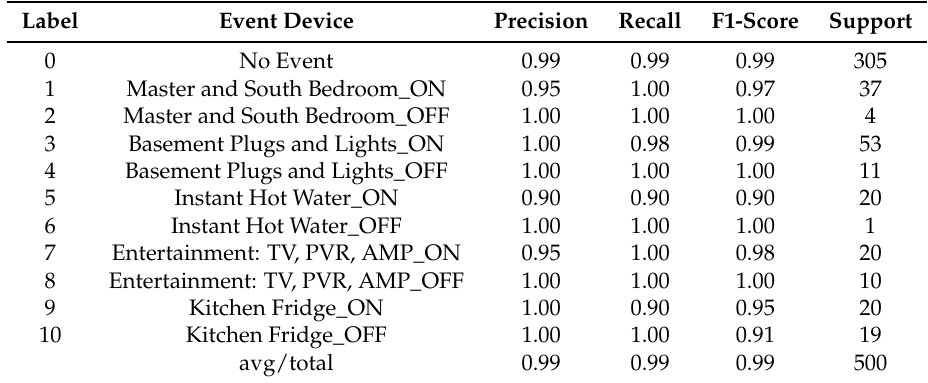
Figure 19. Confusion Matrix of Decision Tree model for classification ON/OFF label on five appliances data in AMPds2. Table 11. Classification result for event detection ON/OFF of each appliance in AMPds2. Event Device Precision Recall